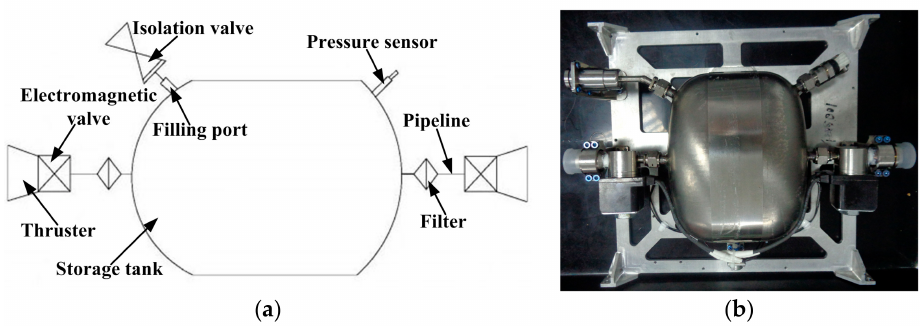
Figure 1. Propulsion system composition ( a ) design diagram; and ( b ) the actual propulsion